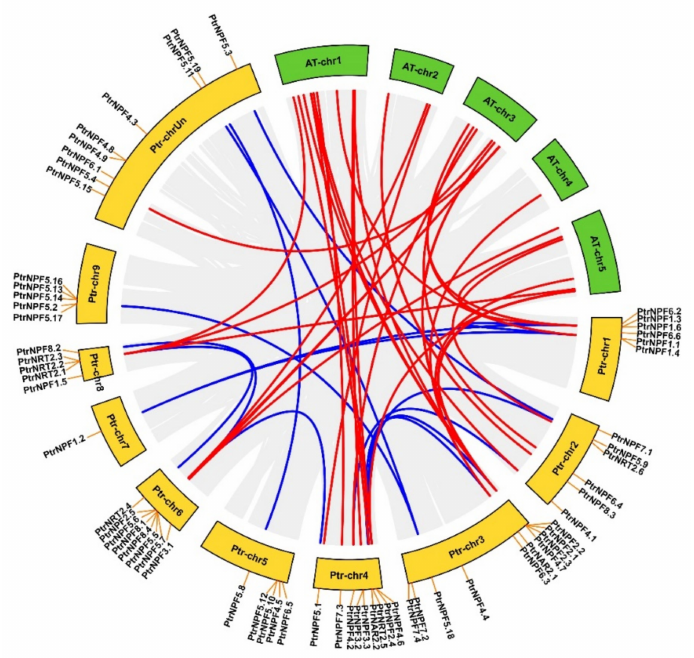
Figure 2. Analysis of evolutionary relationship and gene location of NRT family members in P. trifoliata . The red lines were the syntenic gene pairs among A. thaliana and P. trifoliata genomes. The blue lines were the syntenic gene pairs of P. trifoliata . Chr referred to chromosome. The location of NRT genes on chromosomes were